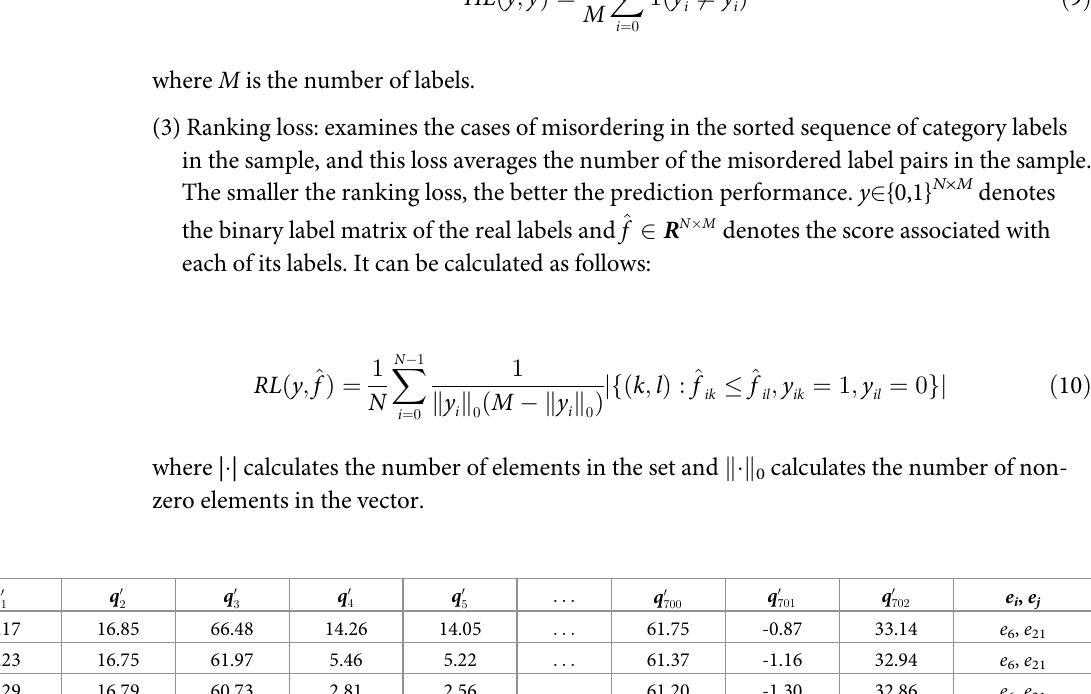
where M is the number of labels. (3) Ranking loss: examines the cases of misordering in the sorted sequence of category labels in the sample, and this loss averages the number of the misordered label pairs in the sample. The smaller the ranking loss, the better the prediction performance. y 2 {0,1} N × M denotes the binary label matrix of the real labels and ^ f 2 R N � M denotes the score associated with each of its labels. It can be calculated as follows: